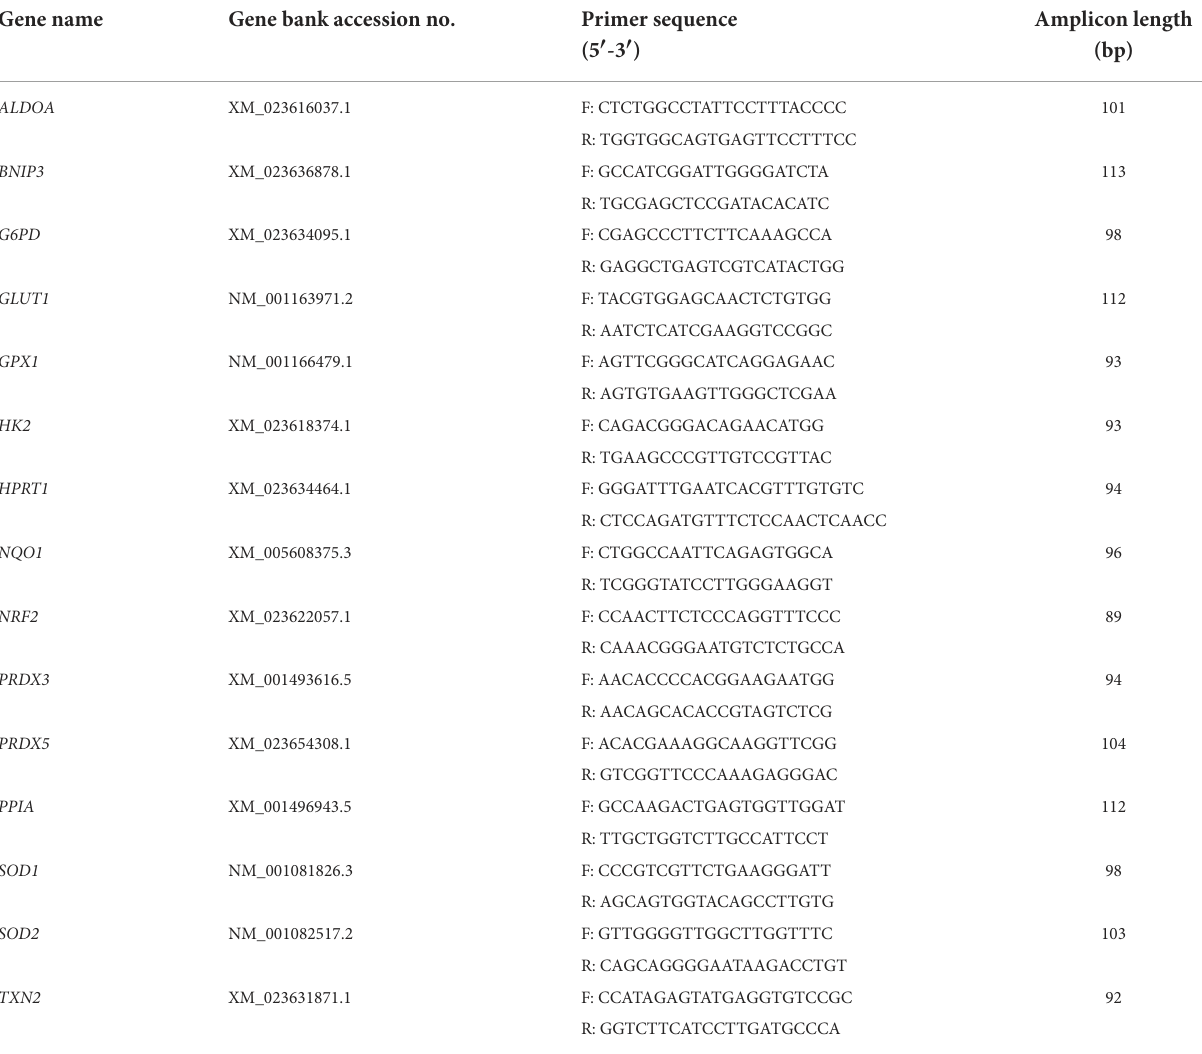
TABLE 1 Primers used for